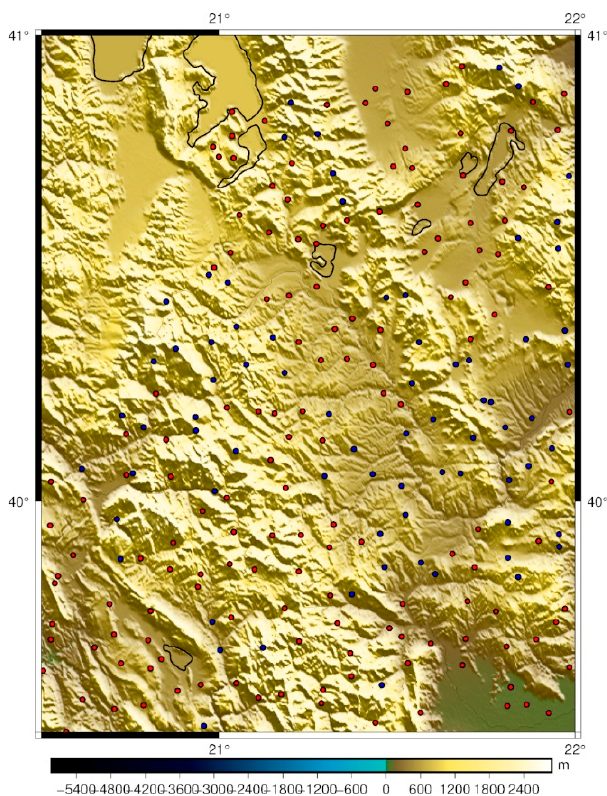
Figure 16. GNSS/levelling BMs over Pindos with improved differences when using the LSC com- bined model (blue dots) and BMs where the LSC with land gravity is better (red